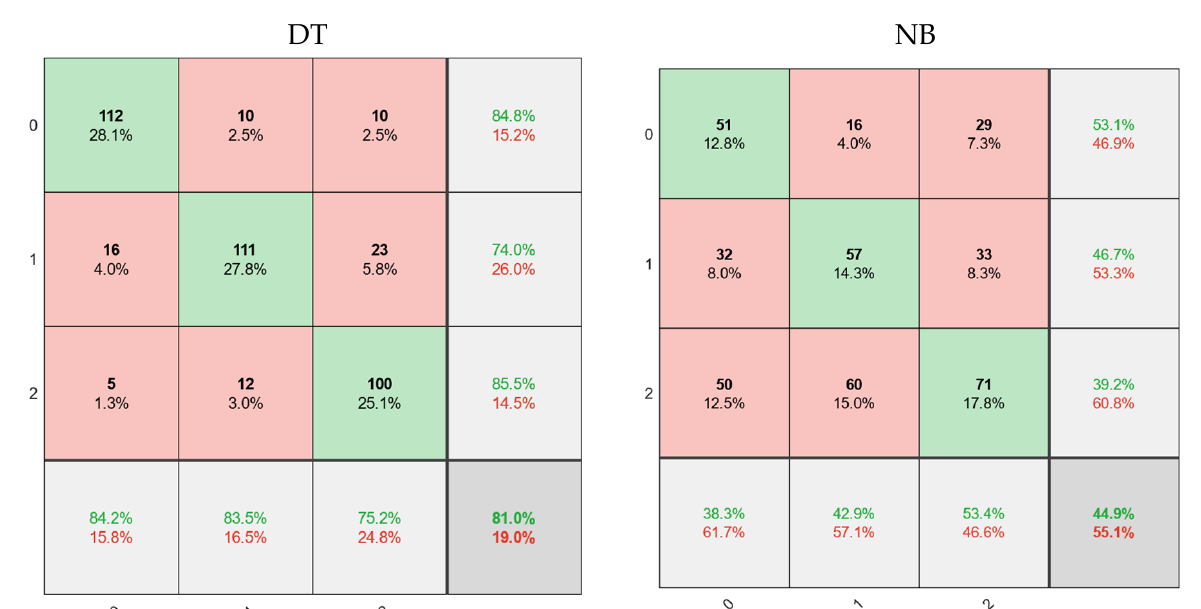
Figure 3. Confusion matrices for classifying or diagnosing tumor type and disease.